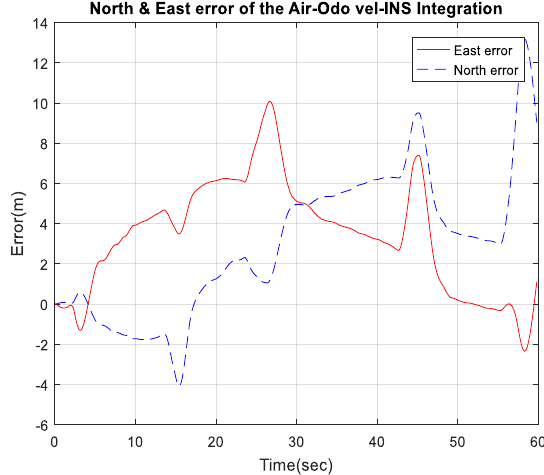
Figure 14. Errors in north and east directions of the Air-Odo alone with additional weight and INS solution during GNSS signal outage for 60 Secs.